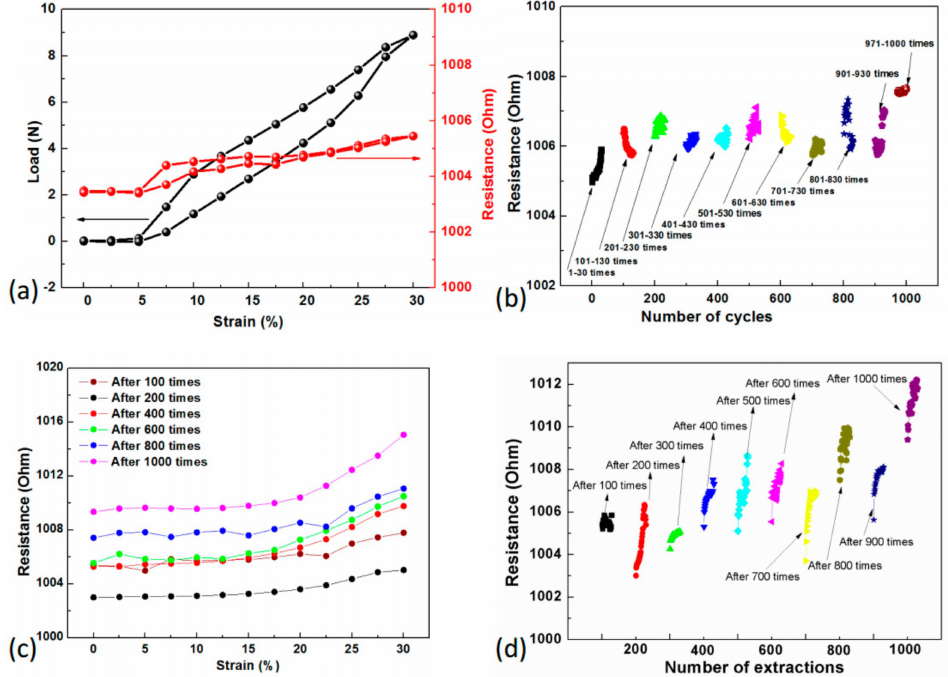
Figure 8. Electrical response of the helical connection in the woven FCB assembly. ( a ) Load-strain and resistance-strain relation; ( b ) Resistance variation in cyclically stretching process; ( c ) Resistance-strain relation after di ff erent times of extraction; ( d ) Resistance variation over di ff erent times of